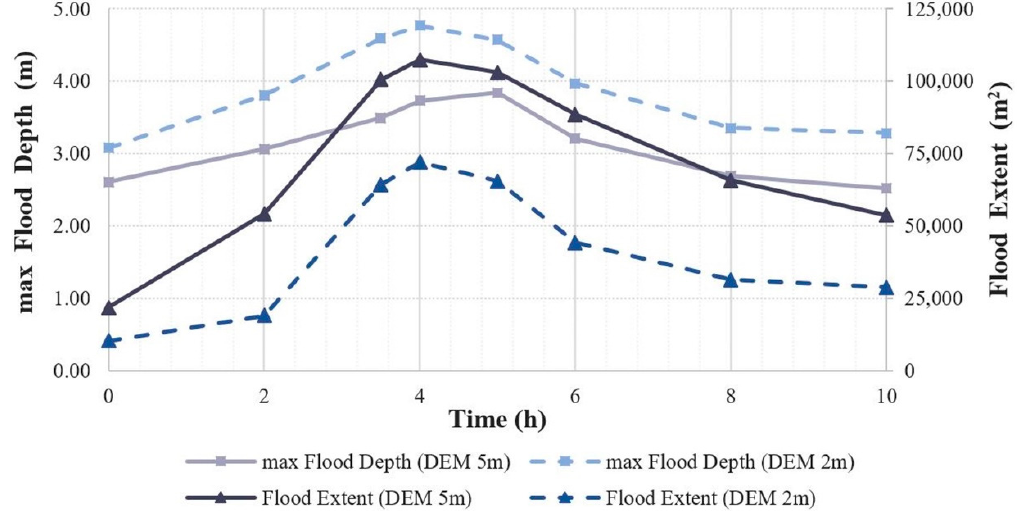
Figure 10. Maximum flood depth (m) and flood extent (m 2 ) variations from the beginning till the end of the simulation, by using the coupled 1D / 2D HEC-RAS model, at both high-resolution DEMs.